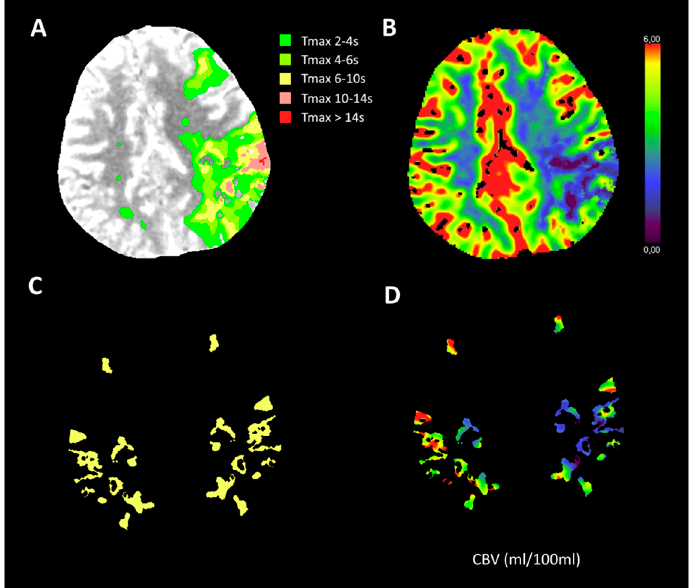
Figure 1. Illustration of one measure as a candidate for baseline CTP-based collateral score: relative CBV multiplied by the total volume of brain tissue defined by time-to-maximum (Tmax). ( A ): Areas with various Tmax value ranges; ( B ): The corresponding CBV values of A (mL/100 mL); ( C ): Mask for Tmax 6–10 s. The contralateral mask is acquired by mirroring the ipsilateral mask using the midline; ( D ): CBV within mask C. The score is the mean CBV of the ipsilateral masked volume relative to the mean CBV of the contralateral masked volume multiplied by the total volume of all the voxels with a Tmax value of 6–10